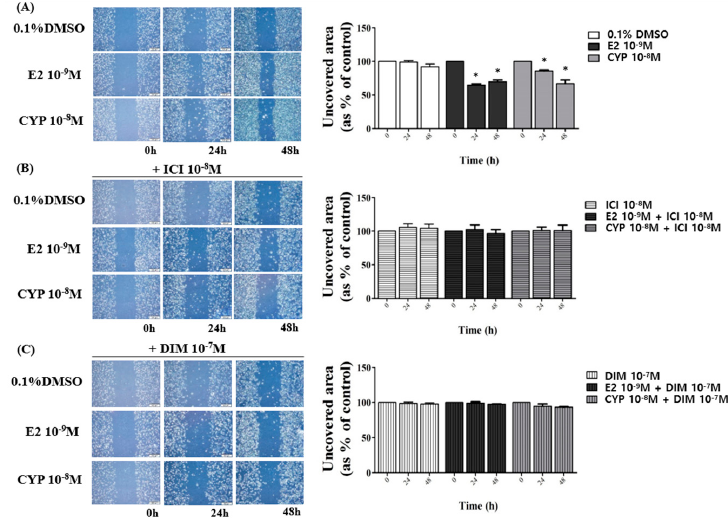
Figure 4. Effects of ICI 182,780 or DIM on E2- or CYP-induced Ishikawa endometrial cancer cell migration. Cells were treated with ( A ) 0.1% DMSO, E2 (10 − 9 M), CYP (10 − 8 M), ( B ) a mixture of E2 (10 − 9 M) or CYP (10 − 8 M) and ICI (10 − 8 M), or ( C ) a mixture of E2 (10 − 9 M) or CYP (10 − 8 M) and DIM (10 − 7 M), respectively, then scratched with a 1 mL micropipette tip. The images presenting the recovery of wounded area were captured at 0, 24, and 48 h using a microscope at a magnification of 40×. The percentage of the wound recovery area at each time point was calculated. The experiment was repeated three times, and data are presented as the means ± SD. *: Mean values were significantly differentiated from 0 h of each treatment, p < 0.05 (Dunnett’s multiple comparison test).